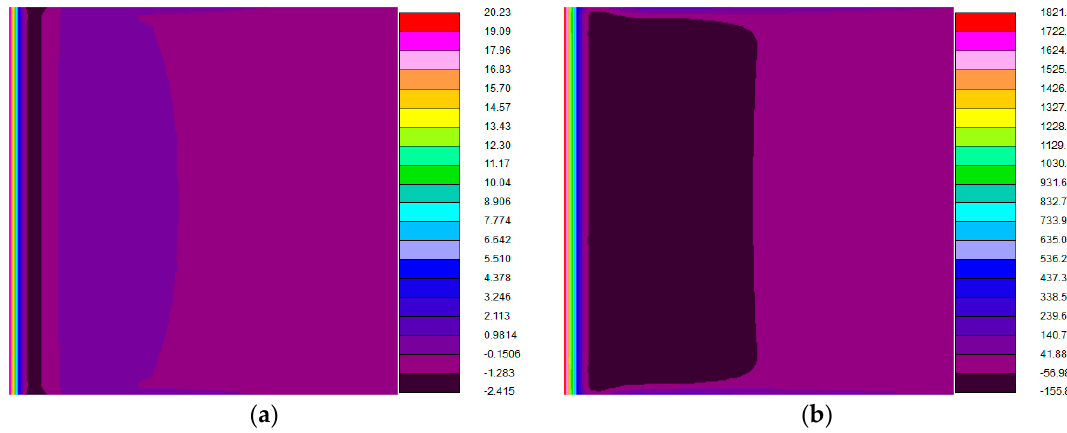
Figure 12. The plate LHC heat flux distributions of parallel-flow plate heat exchanger heat transfer model with LHC ( a ) Balanced flow; ( b ) Unbalanced flow.